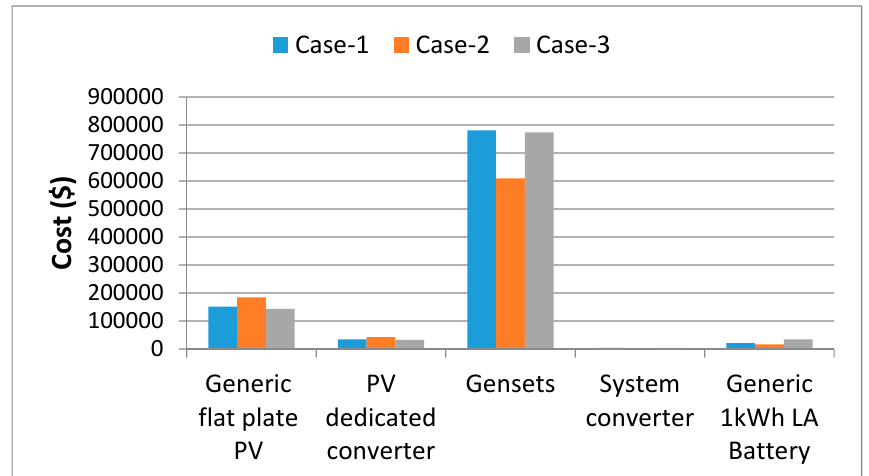
Figure 15. Cost incurred from different equipment.